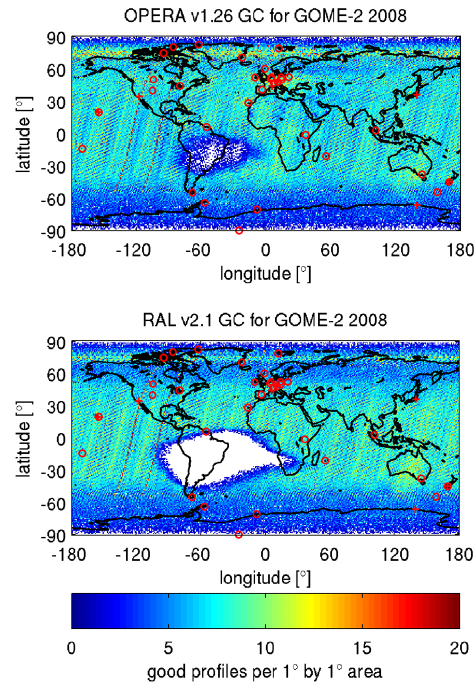
Figure 1. Spatial distribution of “good” (not screened) GOME-2 profiles (2008 only) in the OPERA v1.26 and RAL v2.1 global cov- erage (GC) data sets. Contributing ozonesonde and lidar stations are indicated by red circles and crosses, respectively.